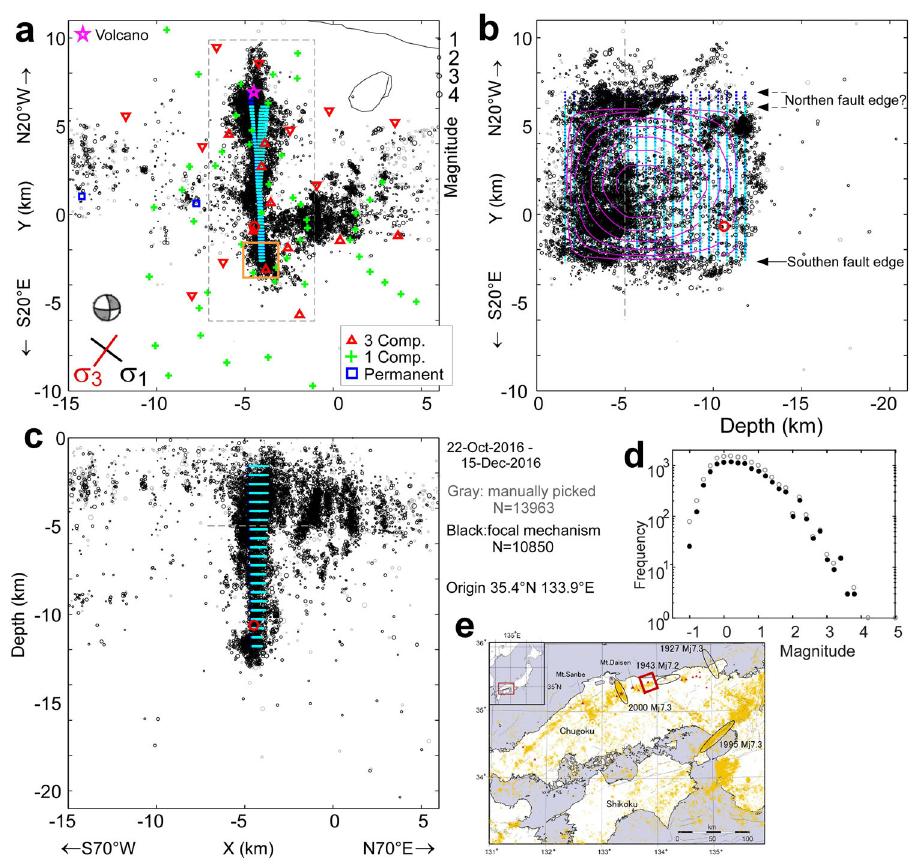
Fig. 2 Distribution of hypocentres and aftershock observation stations. a Plan view. Black circles are aftershocks that occurred from October 22 to December 15, 2016, for which focal mechanisms were determined. Grey circles were aftershocks that were manually picked. Locations of temporary seismic stations for one- and three-component seismographs and permanent stations (operated by the National Research Institute for Earth Science and Disaster Mitigation, NIED, and the Japan Meteorological Agency, JMA) are indicated by red triangles, green crosses, and dark blue rectangles, respectively. The cyan dots indicate the estimated mainshock fault. The possible locations of the northern edges of the WF are indicated by blue dots from Y = 6.1 to 6.9 km. The orange star indicates a quaternary volcano 39 . The focal mechanism (in the lower hemisphere) of the mainshock determined by JMA is shown by a grey and white beach ball 26 . The mean directions of σ 1 and σ 3 in this area, estimated from stress inversion analyses, are shown by black and red lines, respectively. The grey dashed rectangle indicates the area for which detailed analyses were performed. The orange square indicates the areas around the southern edge of the mainshock fault shown in Fig. 4. b Cross-section along the fault strike. The purple contours are the estimated slip distribution in 0.2 m increments, that overlap those of EF and WF (the case of the northern end of Y = 6.1). The red circle indicates the mainshock hypocentre determined by JMA. c Cross-section perpendicular to the fault strike. d Magnitude − frequency distributions of the aftershocks focal mechanisms of which were determined (black dots) and manually picked (grey circles). e Large scale map showing the aftershock region modi fi ed from Fig. 1 of Kawanishi et al. 25